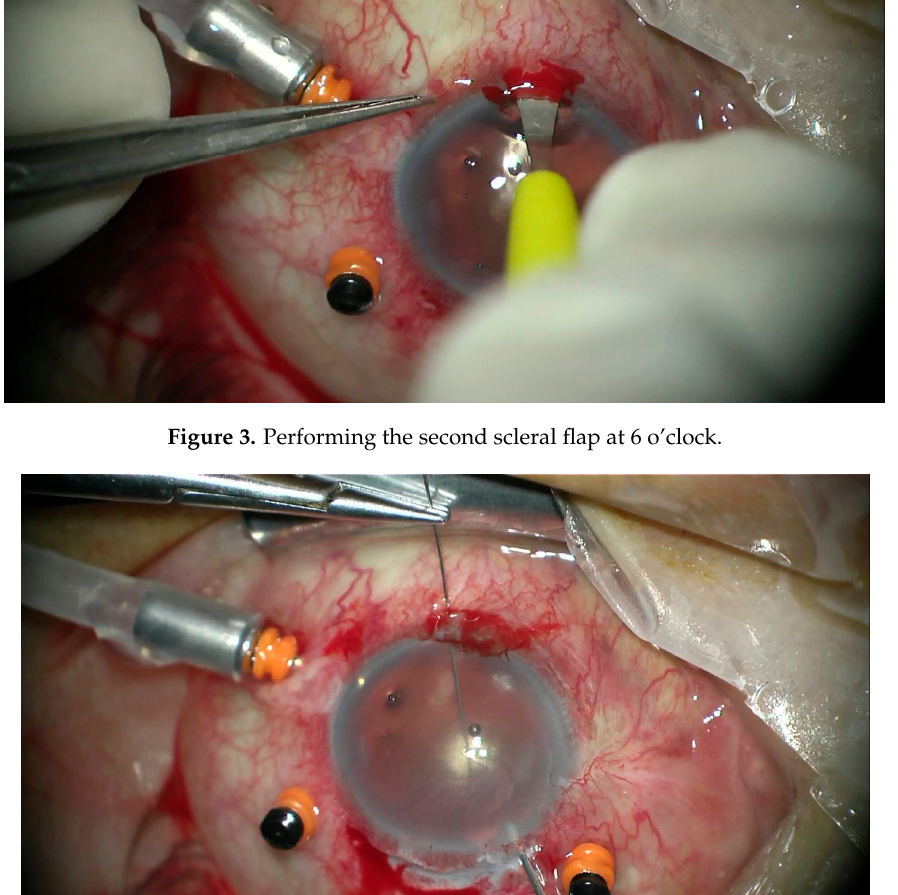
Figure 4. Passing 10-0 proline suture vertically with the straight needle into the anterior chamber under the 6 o’clock scleral flap and engaging in the bore of a 27 gauged bent needle introduced pulled out under the 12 o’clock scleral flap.